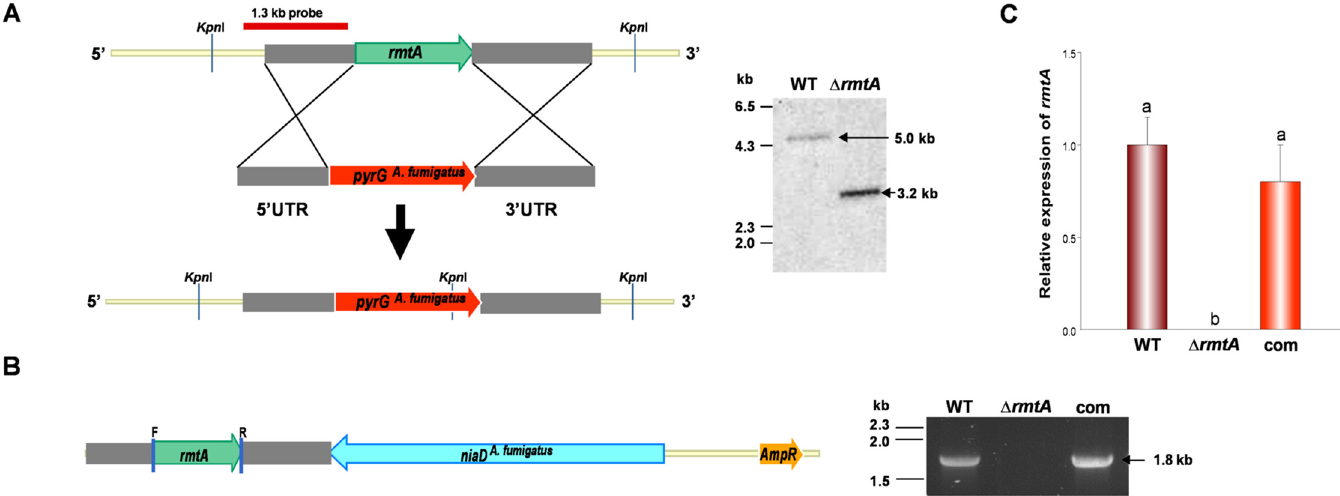
Fig 2. Construction of the rmtA deletion and complementation strains. (A) Diagram showing the gene replacement strategy using the selection marker pyrG from A . fumigatus and Southern blot analysis. Recombination events between the flanking regions are indicated with crosses. KpnI sites are indicated in both the wild-type and modified loci. A 1.3 kb fragment was used as probe as indicated. On the right, Southern blot image confirming of the deletion of rmtA . Genomic DNA from the wild type (WT) and from a selected deletion mutant Δ rmtA was digested with KpnI. Expected 5.0 kb and 3.2 kb bands are shown for WT and Δ rmtA respectively. (B) Linearized representation of the plasmid containing the rmtA wild-type allele. The niaD gene from A . fumigatus was used as selection marker for fungal transformation. Primers OE_RMTA_F and OE_RMTA_R (S1 Table), used for confirmation of the strain, are labeled in this figure as F and R respectively. On the right, gel electrophoresis results showing the presence of a 1.8 kb PCR product, confirming the presence of the wild-type allele in the complementation strain. Wild type and Δ rmtA were used as positive and negative control, respectively. (C) Expression analysis of rmtA by qRT-PCR. Strains were inoculated in PDB (10 6 spores/ml), and cultures were grown for 48 h at 30°C. The error bars represent standard errors. Values were normalized to the expression levels in the wild type, considered as 1. Different letters on the columns indicate values that are statistically different (p <